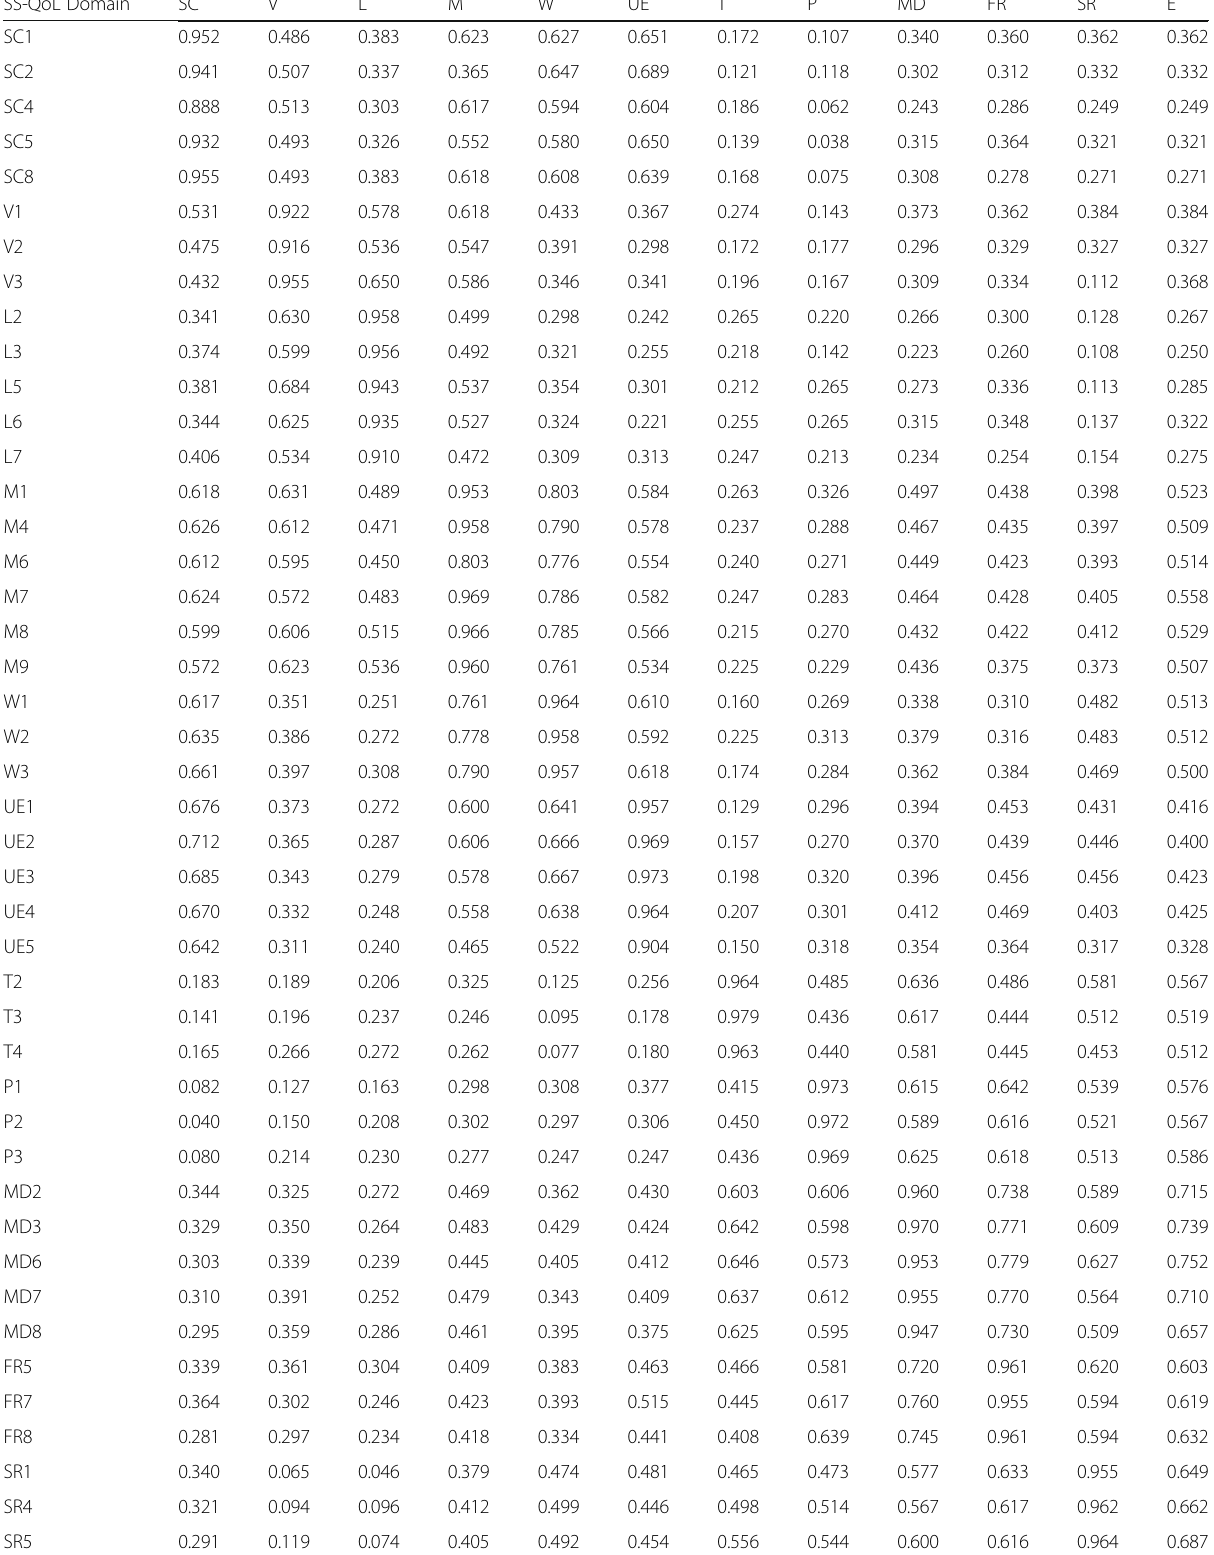
Table 7 Item-domain correlations (discriminant validity) of the Hausa version of the Stroke Specific Quality of Life 2.0 ( n = 86) SS-QoL